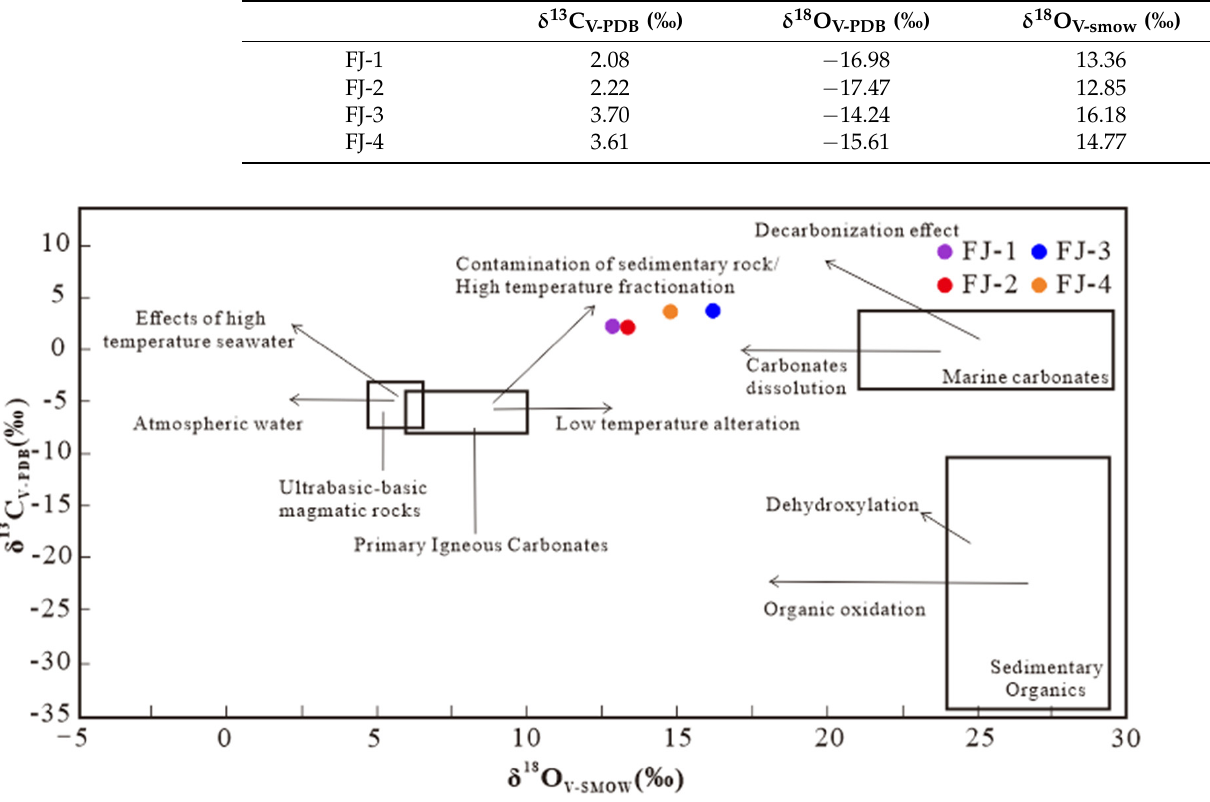
Table 2. C-O isotopic compositions (‰) of FJ-1, FJ-2, FJ-3, and FJ-4. δ 13 C V-PDB (‰)